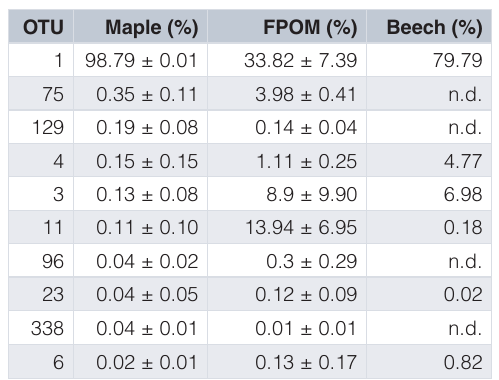
Table 3. Comparison of OTUs on maple leaves (mean of replicates), FPOM (mean of size fractions) and beech leaves with standard deviation when applicable. The table is sorted after the most abundant OTUs on maple leaves in descending order. (n.d. = not detected, based on Dataset